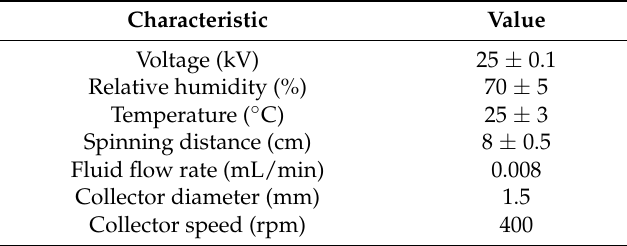
Figure 1. ( a ) Schematic diagram of the preparation process; ( b ) Fourier-transform infrared (FTIR) spectra of prepared membranes; ( c ) Photos of nascent and sintered hollow fiber membranes; ( d ) SEM images of (1) porous glassfiber braided tube; (2) the nascent membrane; (3) the sintered membrane; (4) the whole cross-section of the sintered membrane; ( e ) Thermogravimetric (TG) curves of prepared membranes. Table 1. The parameters of the nascent poly(tetrafluoroethylene)/poly(vinylalcohol) (PTFE/PVA) hollow fiber membranes.